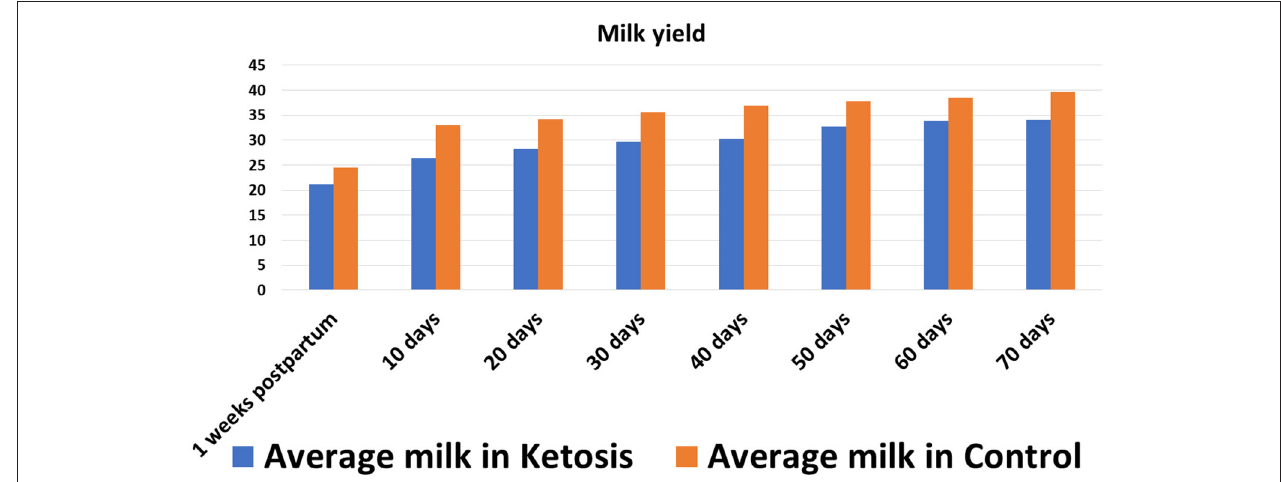
FIGURE 1 | Average milk yield in SCK and CON healthy dairy cows during 0 to 70 days